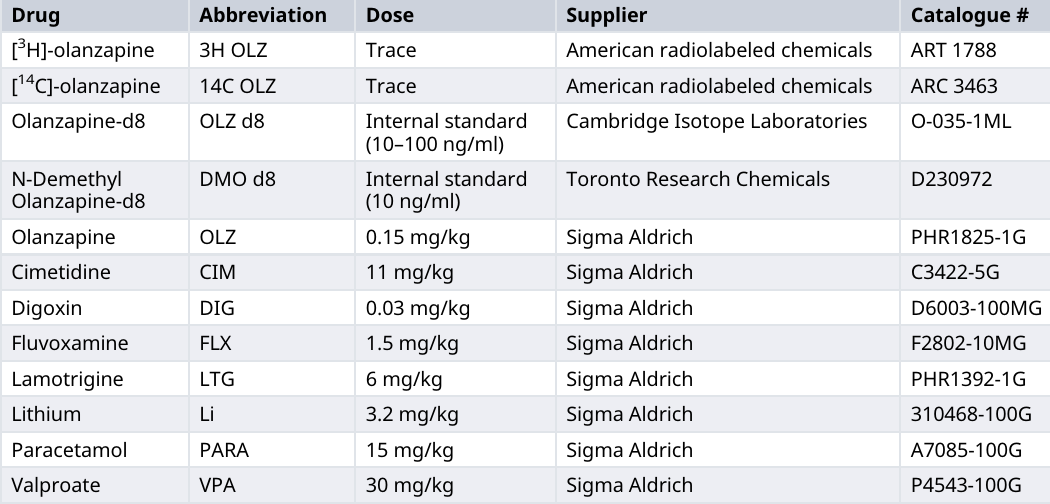
Table 2. List of drugs used, their abbreviation, dose, supplier and catalogue number.